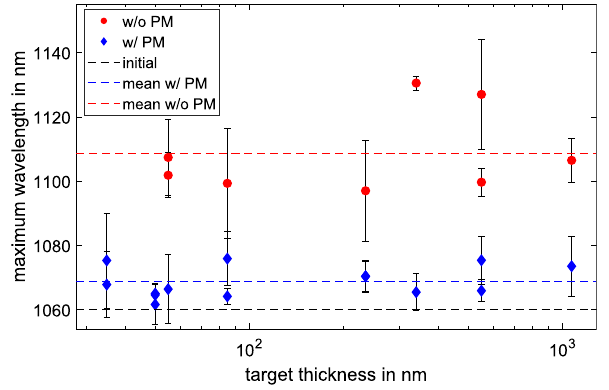
Fig. 3 Measured maximum wavelength. Maximum wavelength of the re fl ected laser pulse for the case with (blue) and without (red) plasma mirrors for different target thicknesses, whereas the uncertainties are given by the peak-to-valley difference between the maximum wavelength at 1 and 10% of the maximum spectral intensity. The dashed lines correspond to the averaged values for each condition. The black dashed line shows the maximum wavelength of the incoming laser